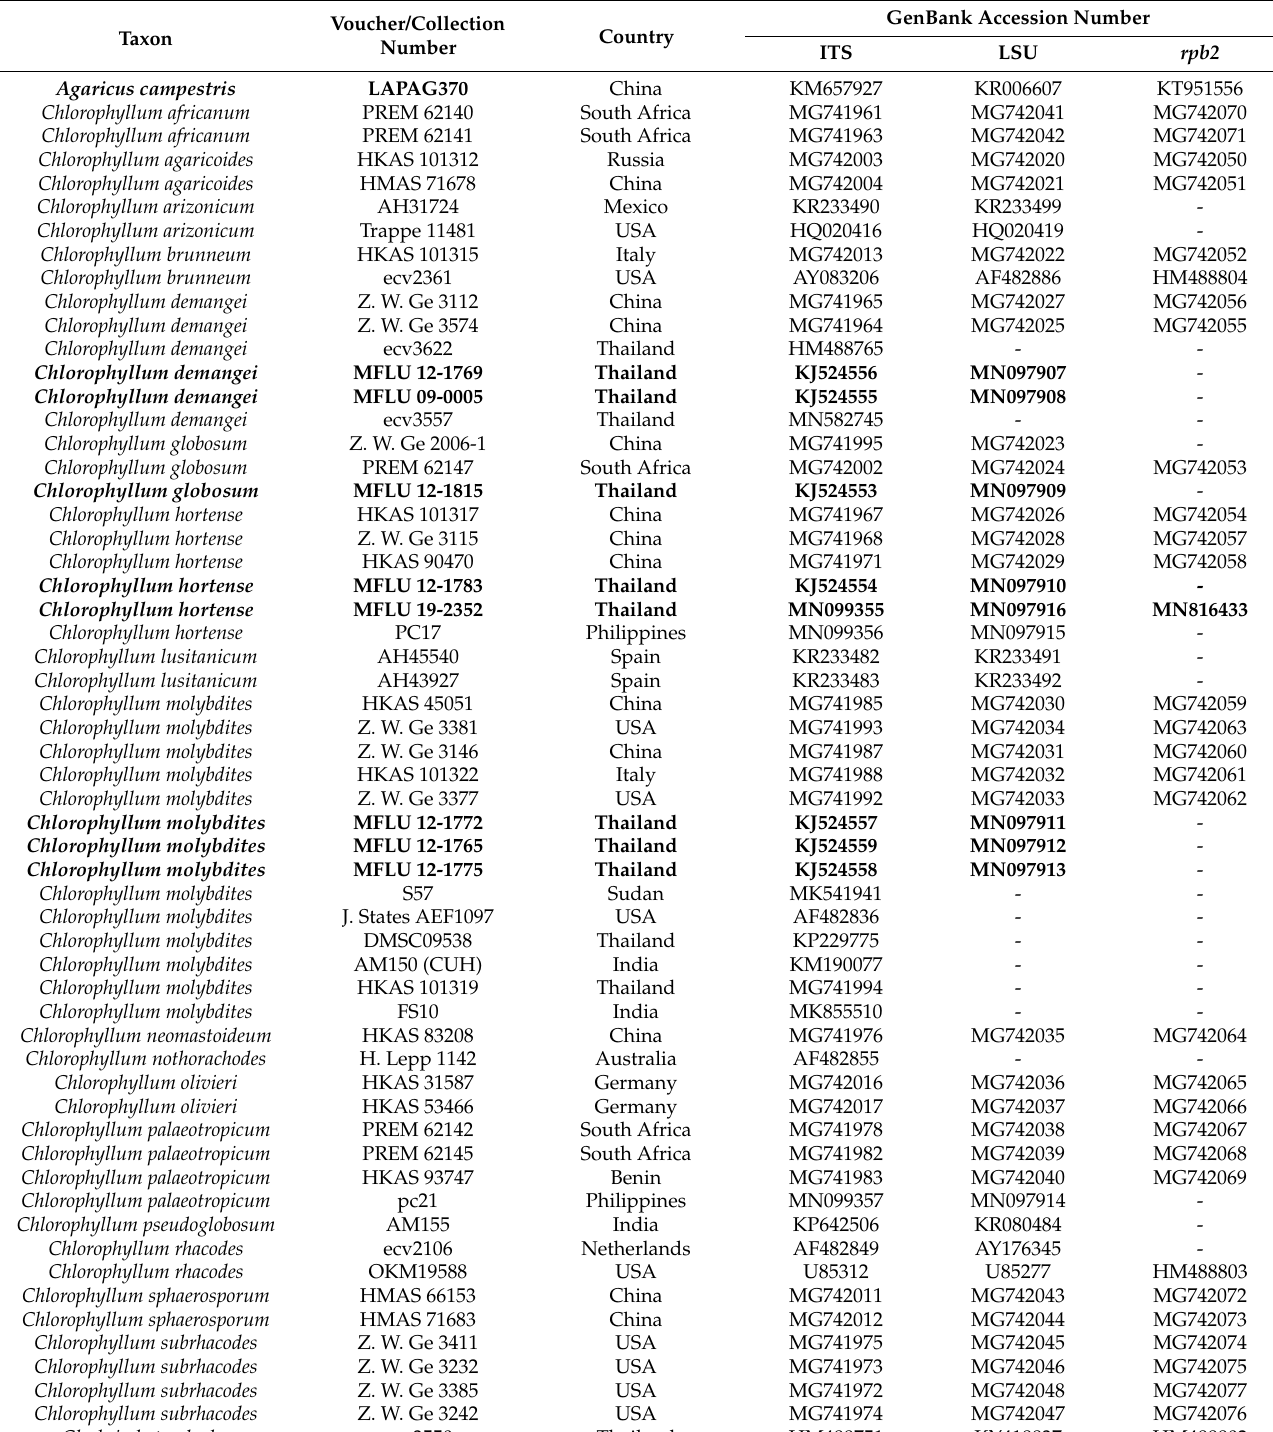
Table 2. List of fungal taxa of second dataset of Chlorophyllum species and their GenBank accession numbers used in molecular analysis of datasets